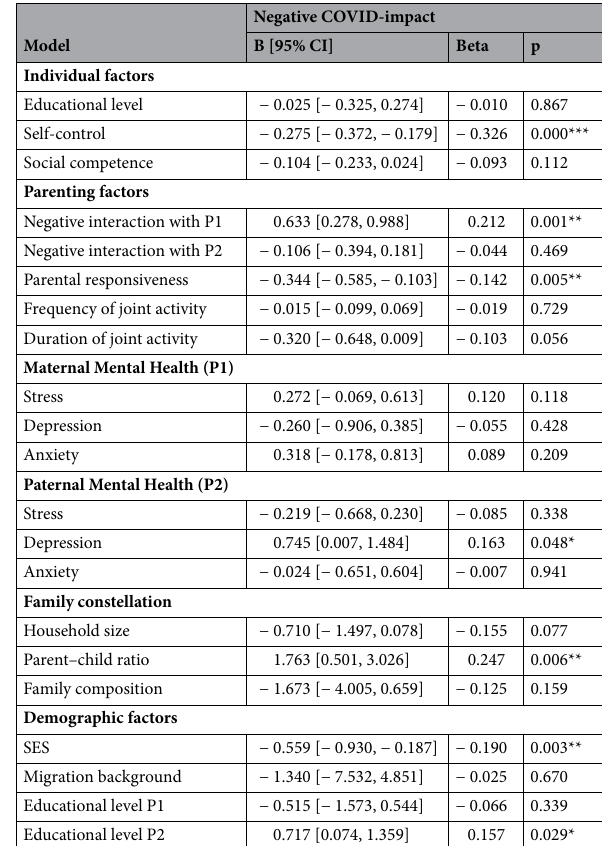
Table 4. R 2 , F-change and significance for all hierarchical Regression Models per risk cluster and